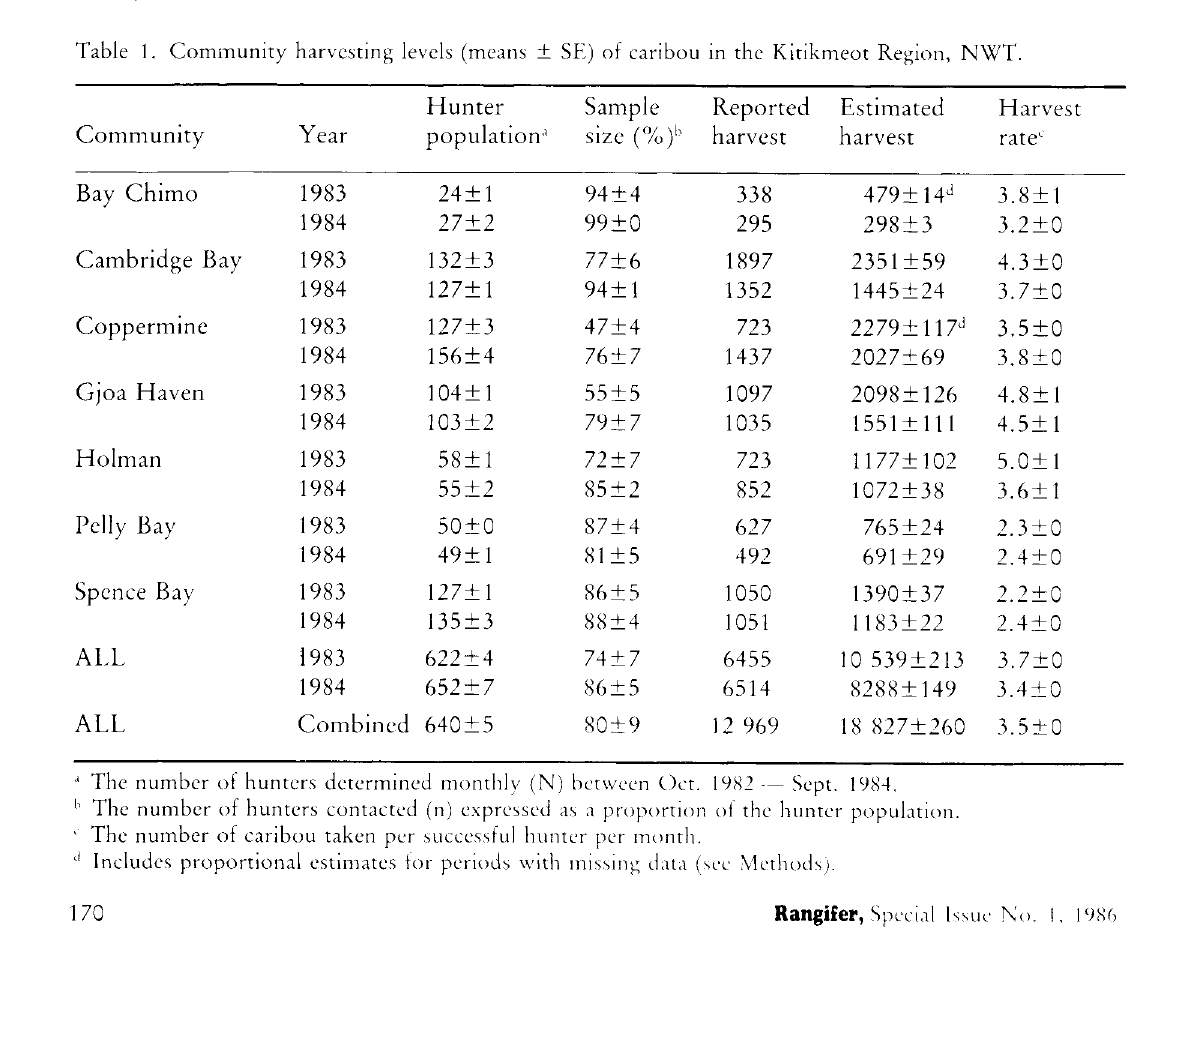
Table 1. Community harvesting levels (means ± SE) of caribou in the Kitikmeot Region, N W T.